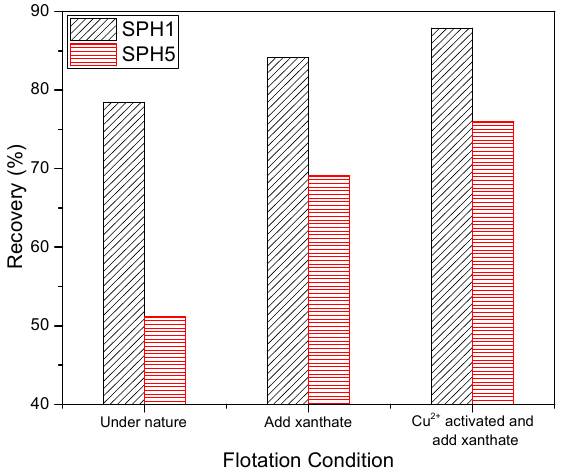
Figure 2. Flotation recovery of sphalerite/marmatite at pH 6.5 in 220 s; concentrations of Cu 2+ and BX are 1 × 10 − 5 and 1 × 10 − 4 mol/L, respectively; the black histogram is for sphalerite (SPH1) and the red histogram is for marmatite (SPH5).